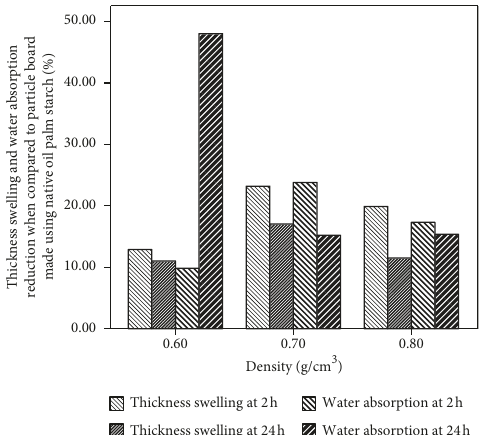
Figure 6: Normalized chart of thickness swelling and water ab- sorption when using OPSMG as a binder compared to wood composites made using OPS as a